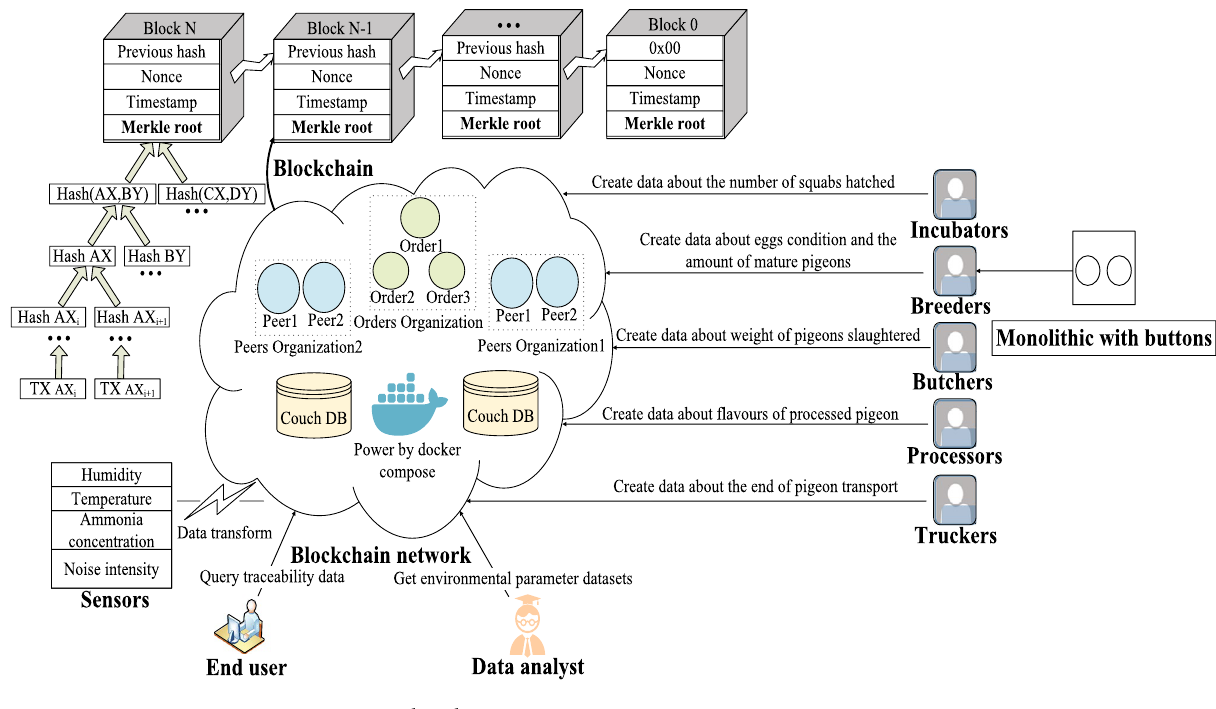
Figure 1. System